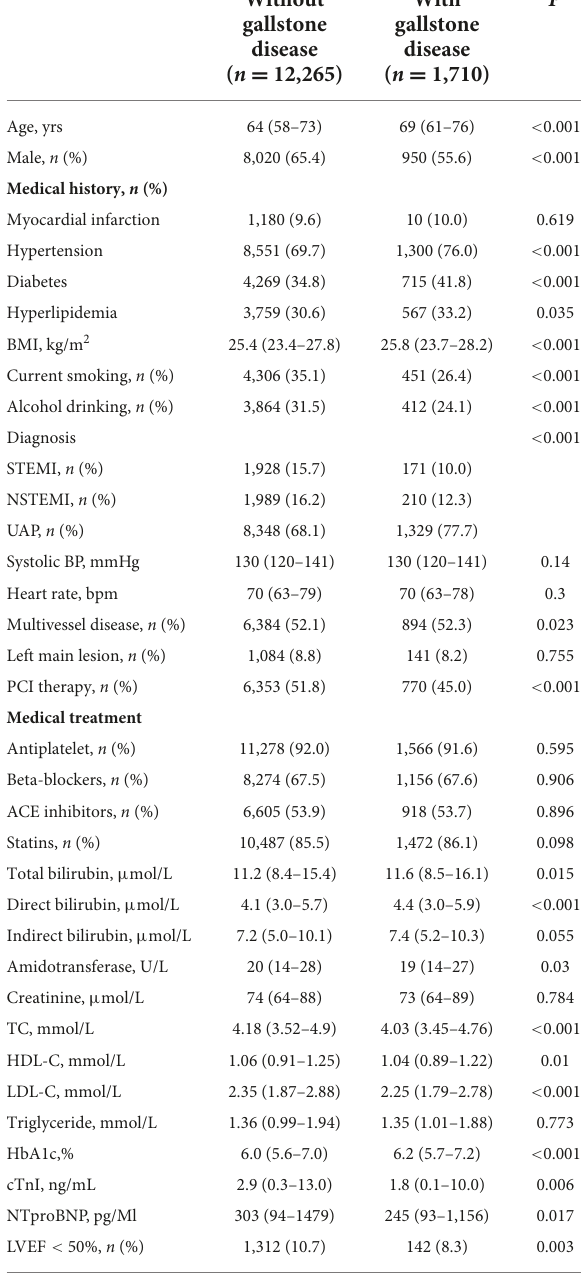
TABLE 1 Baseline characteristics according to the presence of gallstone disease. Without